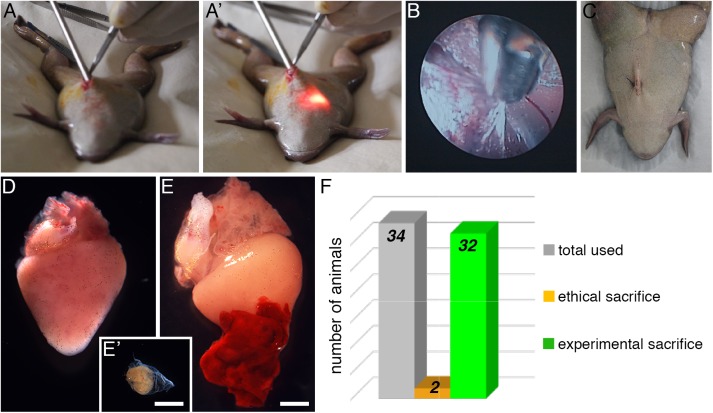
Ventricular resection endoscopic biopsy and animal survival in adult Xenopus laevis.(A-C) Key steps of the heart ventricular biopsy procedure using an endoscope. After an abdominal incision, the endoscope is inserted into the pleuroperitoneal cavity (A), using a xenon light source and light cable (A’) to search for the heart and observe the procedure internally. Biopsy forceps are used to break the falciform ligament, open the pericardial sac (B), then collect a calibrated piece of cardiac tissue from the apical region of the ventricle (see also S1 File). The surgery is ended (C) by performing a single suture to close the incision. (D-E) Comparison of a control non-operated heart (D) with an operated heart, displaying a large blood clot 1 day post-amputation (E), the size of biopsy tissue (E’) collected corresponds to approximately 4% of the ventricle. (F) Graphical representation of survival after the procedure, detailing total number of animals used for the full amputation procedure (n = 34), and animals ethically sacrificed (n = 2) or experimentally sacrificed at the end of the planned protocol (n = 32). Scale bars, 2 mm (D, E and E’).